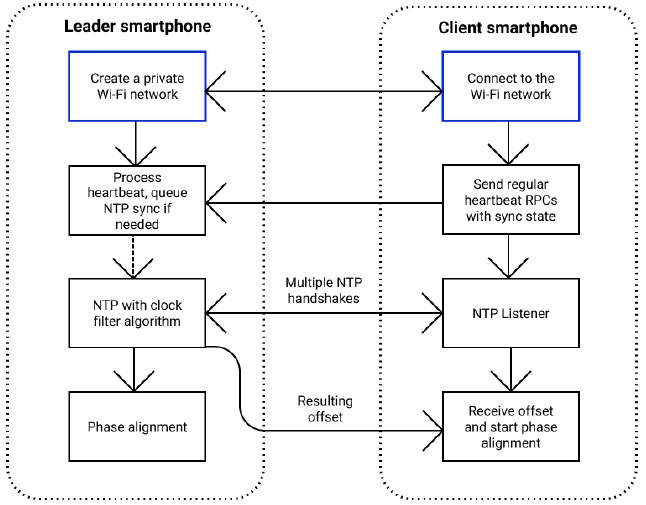
Figure 9. Original libsoftwaresync pipeline.